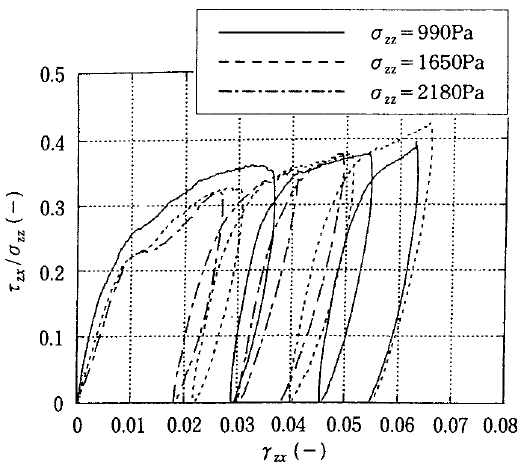
Fig. 15 . Relations between shear stress and strain normalized by σ